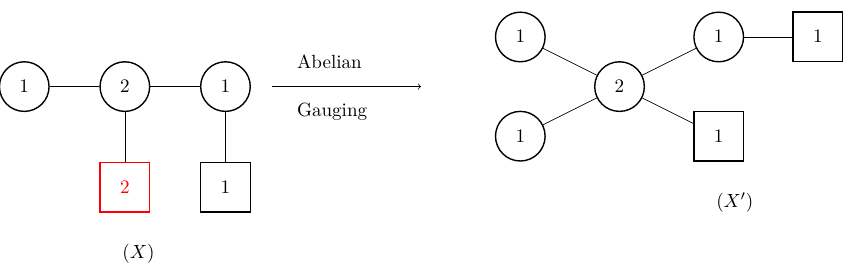
Figure 40 . A U(1) gauging operation on the quiver X leading to the theory X 0 .